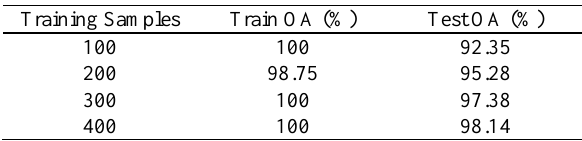
Table 4. Results obtained for classification of PaviaU after training different train